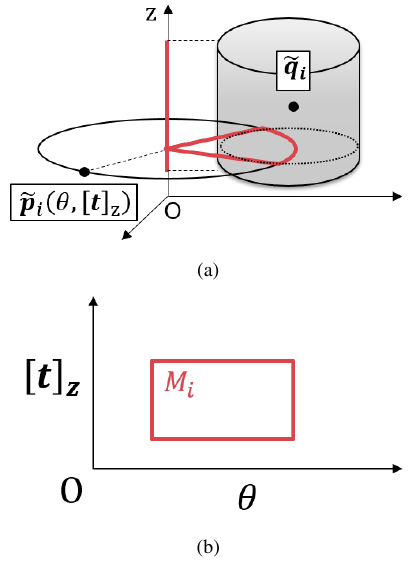
Figure 2. (a) Region ( θ, [ t ] z ) satisfying F i ( θ, [ t ] z ;[ t ] xy ) = 1 can be reviewed as (b) rectangle regions on 2D space.